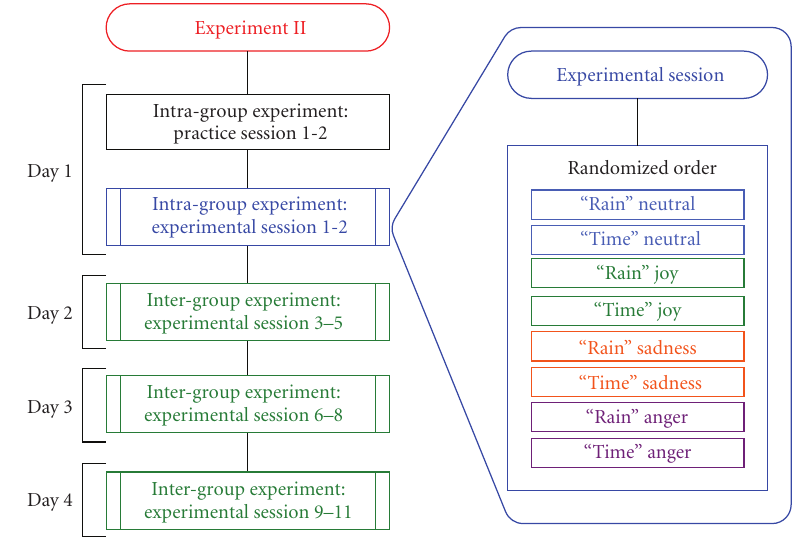
Figure 19: Flow of Experiment II.